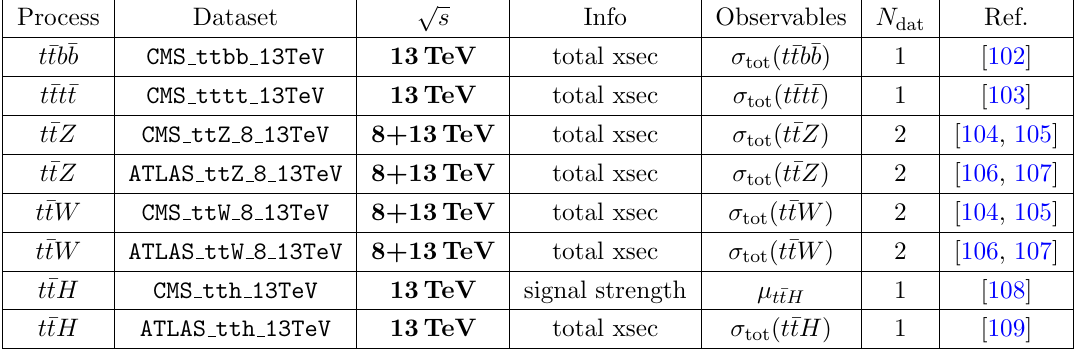
Table 3 . Same as table 2 now for t (cid:22) t in association with heavy quarks, with weak vector bosons, and with the Higgs boson.